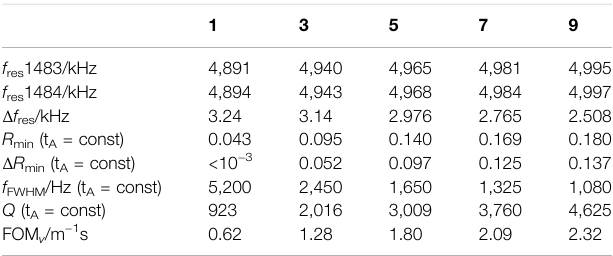
TABLE 1 | Characteristic values of the 1, 3, 5, 7, and 9PnC at a constant analyte layer thickness of 153 µm.